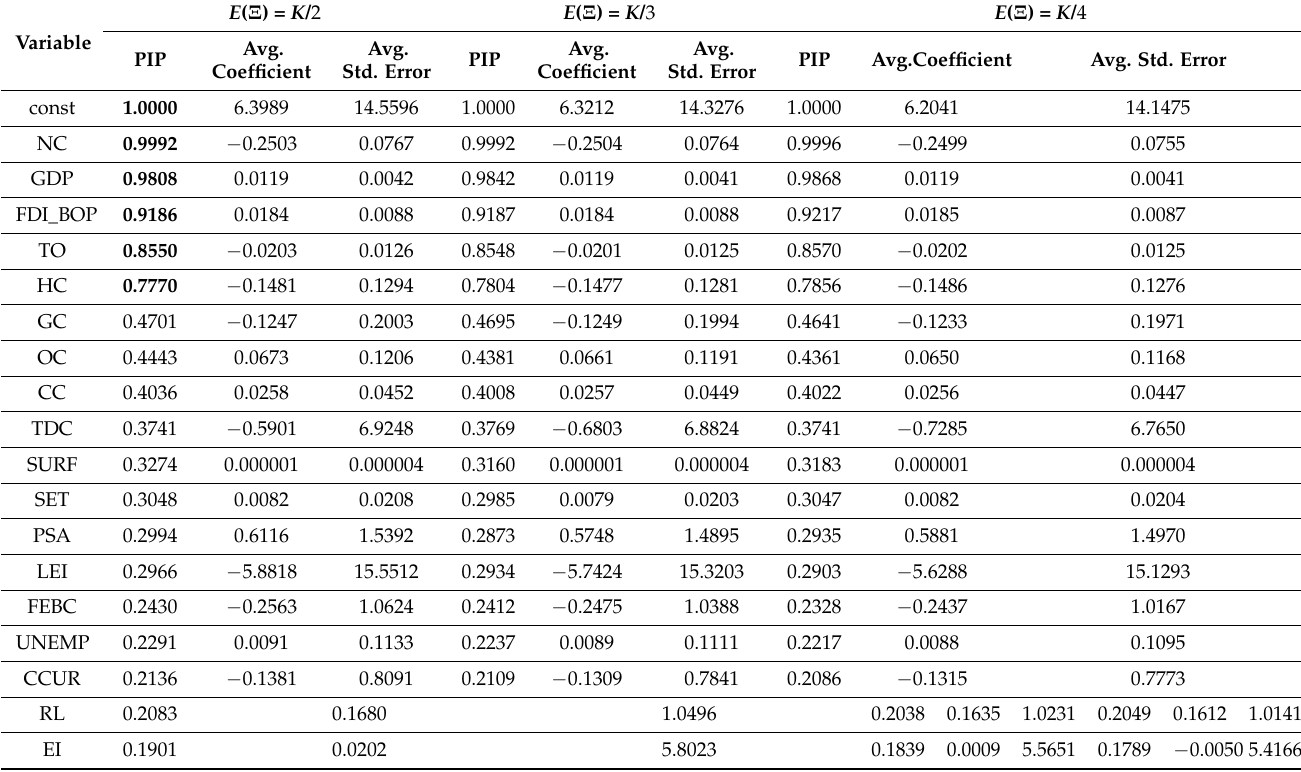
Table 5. Posterior estimates of renewable consumption determinants in 2018 for different average prior model